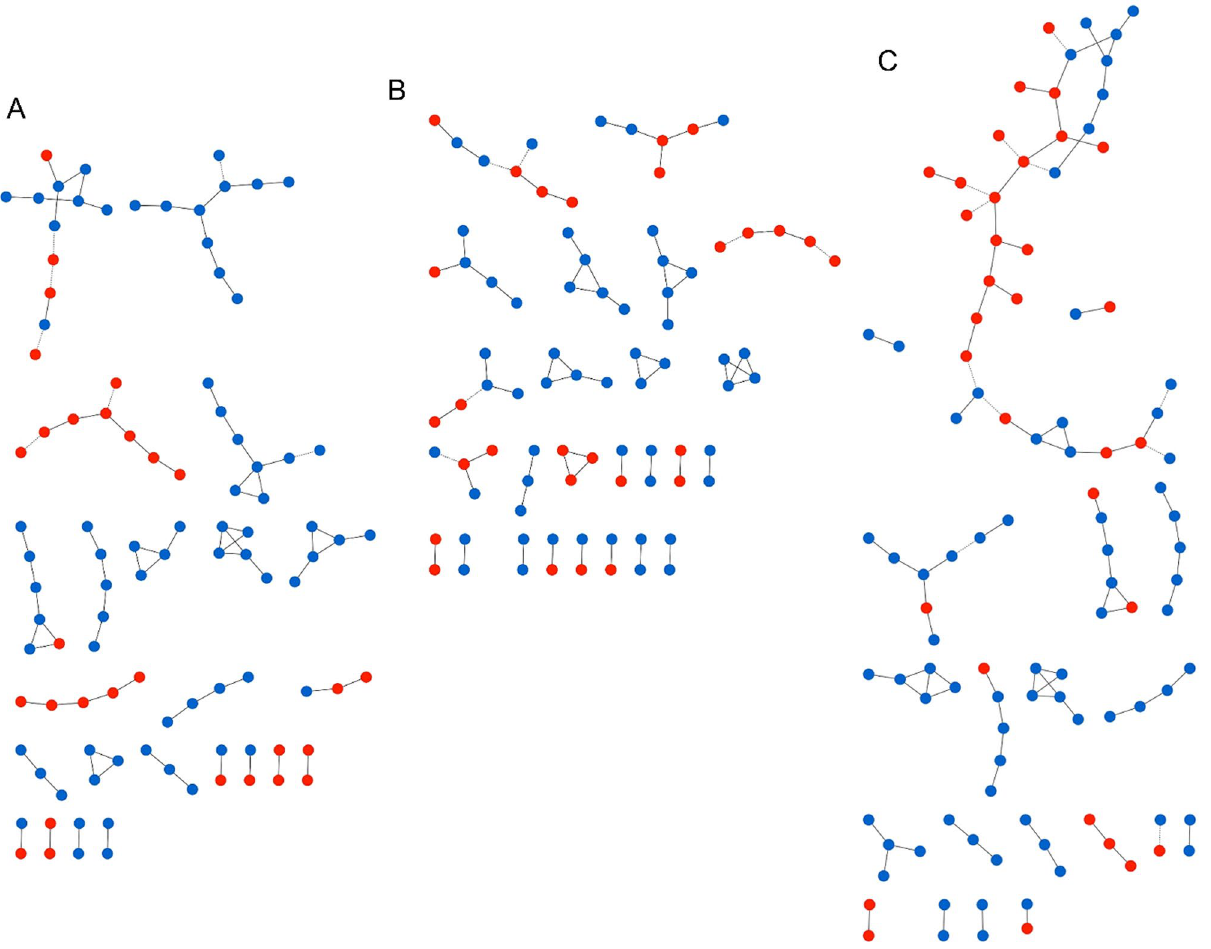
Figure 1. Network representation of Gaussian graphical models (GGM) of the serum exposome and metabolome measured in the whole cohort ( A ), in women office workers ( B ), and in women firefighters ( C ). Blue and red nodes represent endogenous metabolites and environmental chemicals, respectively. Edges connecting nodes represent significant partial correlations at FDR < microbial-derived secondary bile acid (sulfolithocholylglycine, PCC = 0.12, p = 2.6 × 10 –5 ), while perfluorooc- tane sulfonic acid (PFOS) was correlated with one inflammatory signaling molecule (15d PGD2, PCC = − 0.13, p = 2.4 × 10 –4 ) and calcitriol, the biologically active form of vitamin D (PCC = 0.14, p = 4.4 × 10 –5 ) in women FF (Fig. 3B). In women OW, we observed a lower number of exposure-metabolite interactions (Table 1). We found that several phenols, including 4-hexyloxyphenol, butyl paraben, octylphenol diethoxylate and pentachlorophe-